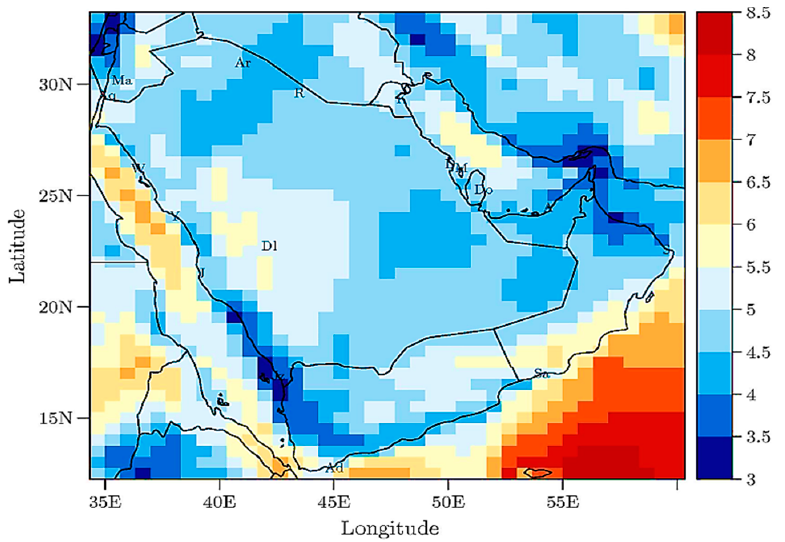
Figure 6. Average wind speed (m s − 1 ) of the GCC region is computed at 50 m. Copyright © 2021 Elsevier [87].